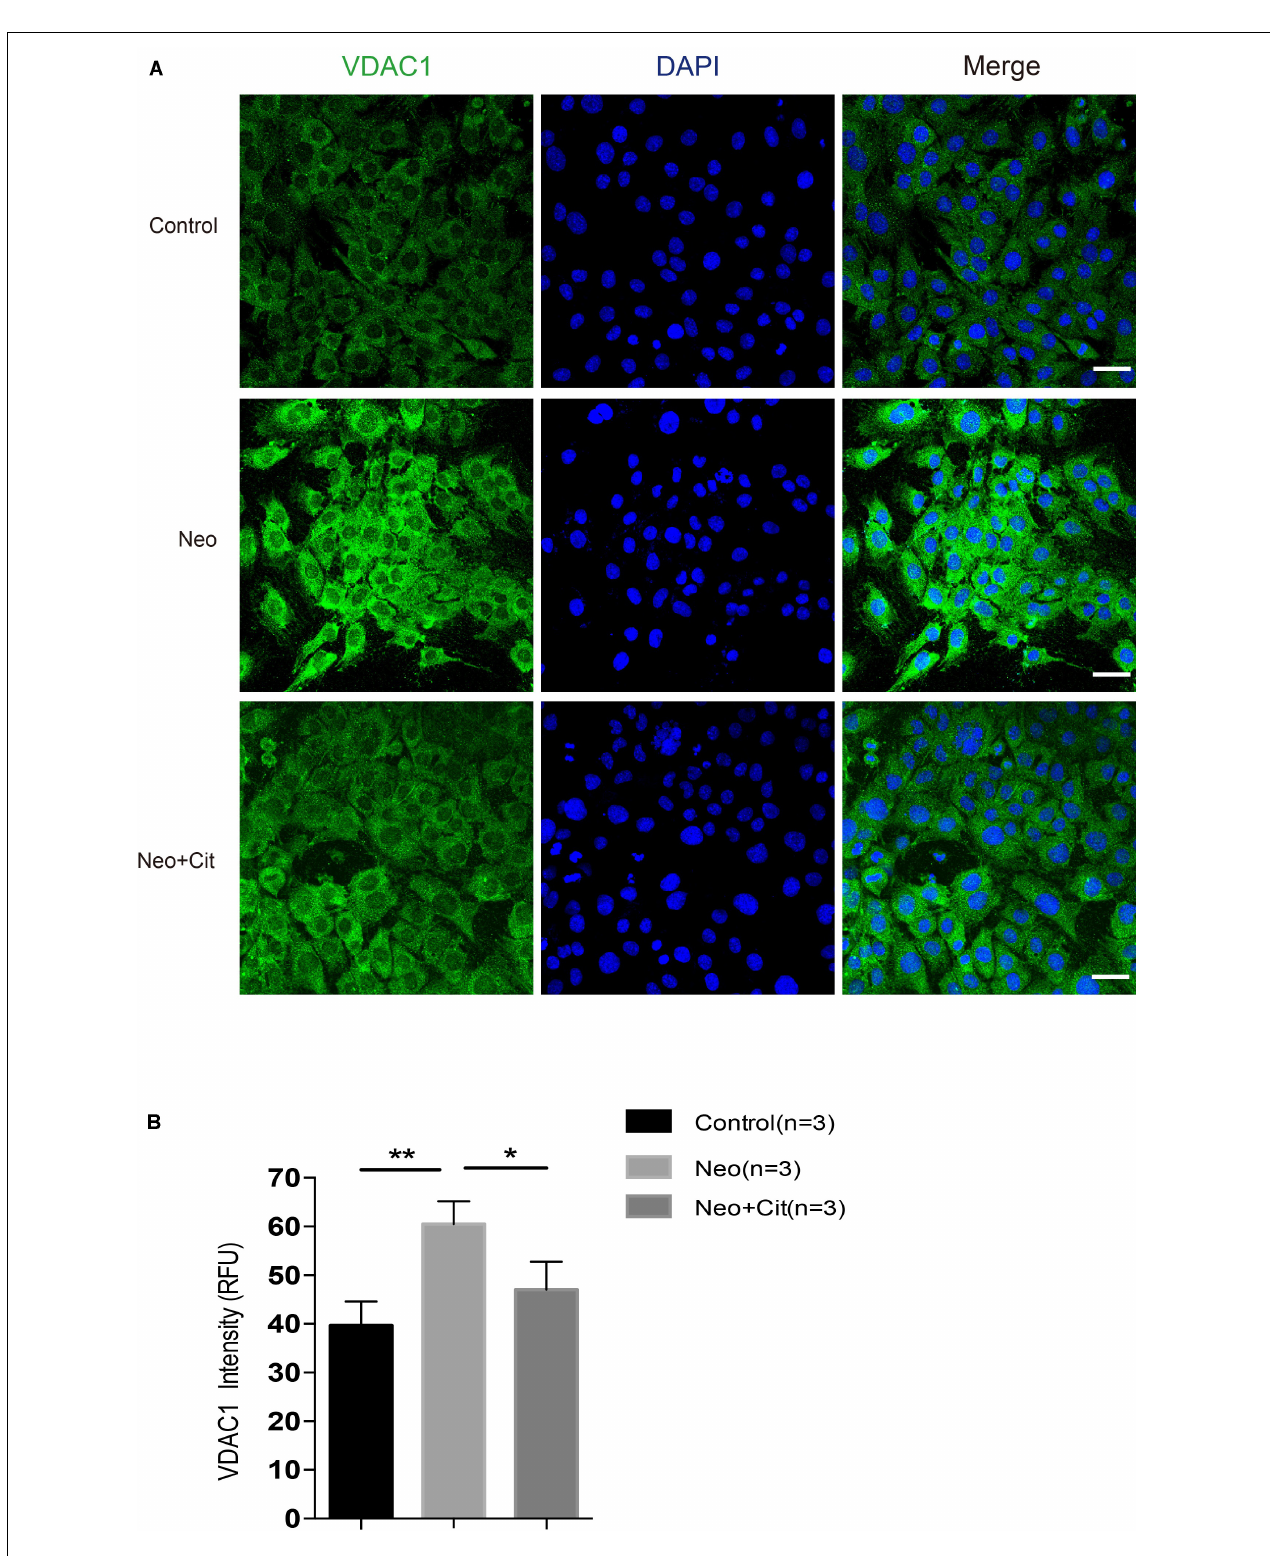
FIGURE 8 | Citicoline downregulates the expression of the VDCA1 of HEI-OC-1 cells after neomycin exposure. (A) The three groups of HEI-OC-1 cells were labeled using the mitochondrial marker VDAC1 and DAPI double staining. (B) Quantitative analysis histogram of VDAC-1 staining intensity scanning in (A) . Data are shown as mean ± SD. * p < 0.05, ** p < 0.01, *** p < 0.001. Scale bars = 20 µ m.